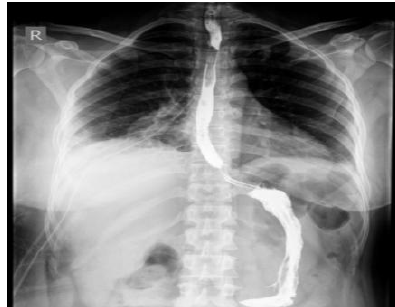
Figure 3. Intraoperative view of esophageal diverticula via right thoracotomy